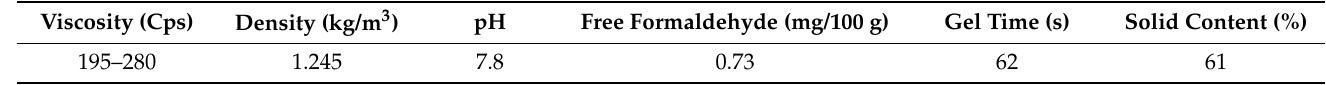
Table 1. Chemical and physical properties of Urea–formaldehyde Resin. Viscosity (Cps) Density (kg/m 3 ) pH Free Formaldehyde (mg/100